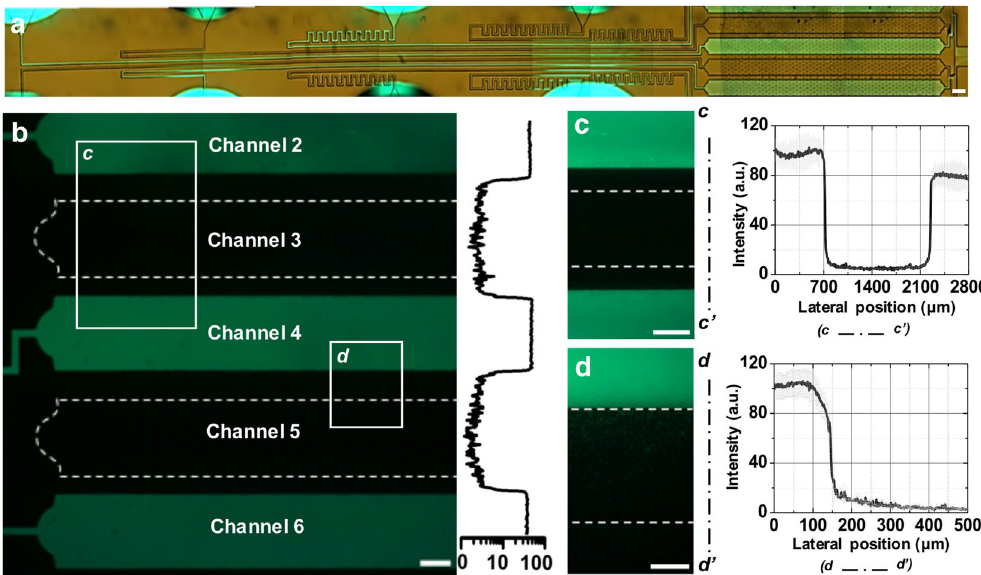
Figure 2. Confirming the sealing between the PDMS chip and the modular hydrogel sheet, including biotin- conjugated polystyrene beads, without any cross-contamination. ( a ) Bright image of the microfluidic assembly platform where the streptavidin–FITC solution passed through only the even-numbered microchannels. ( b – d ) The brightness of the encapsulated polystyrene beads and the leaked FITC solution were examined for the sealing effect of the microfluidic assembly platforms in fluorescent images and intensity profiles. ( c , d ) Show enlarged images and their intensity profiles as indicated by the boxes in panel b. Scale bar = 500 µ m ( b , c ) and 100 µ m ( d